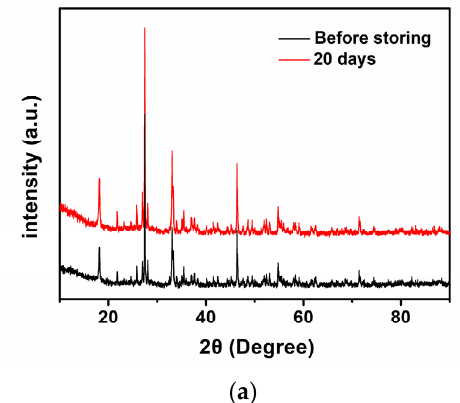
Figure 6. XRD patterns of the zinc anode stored for various days.